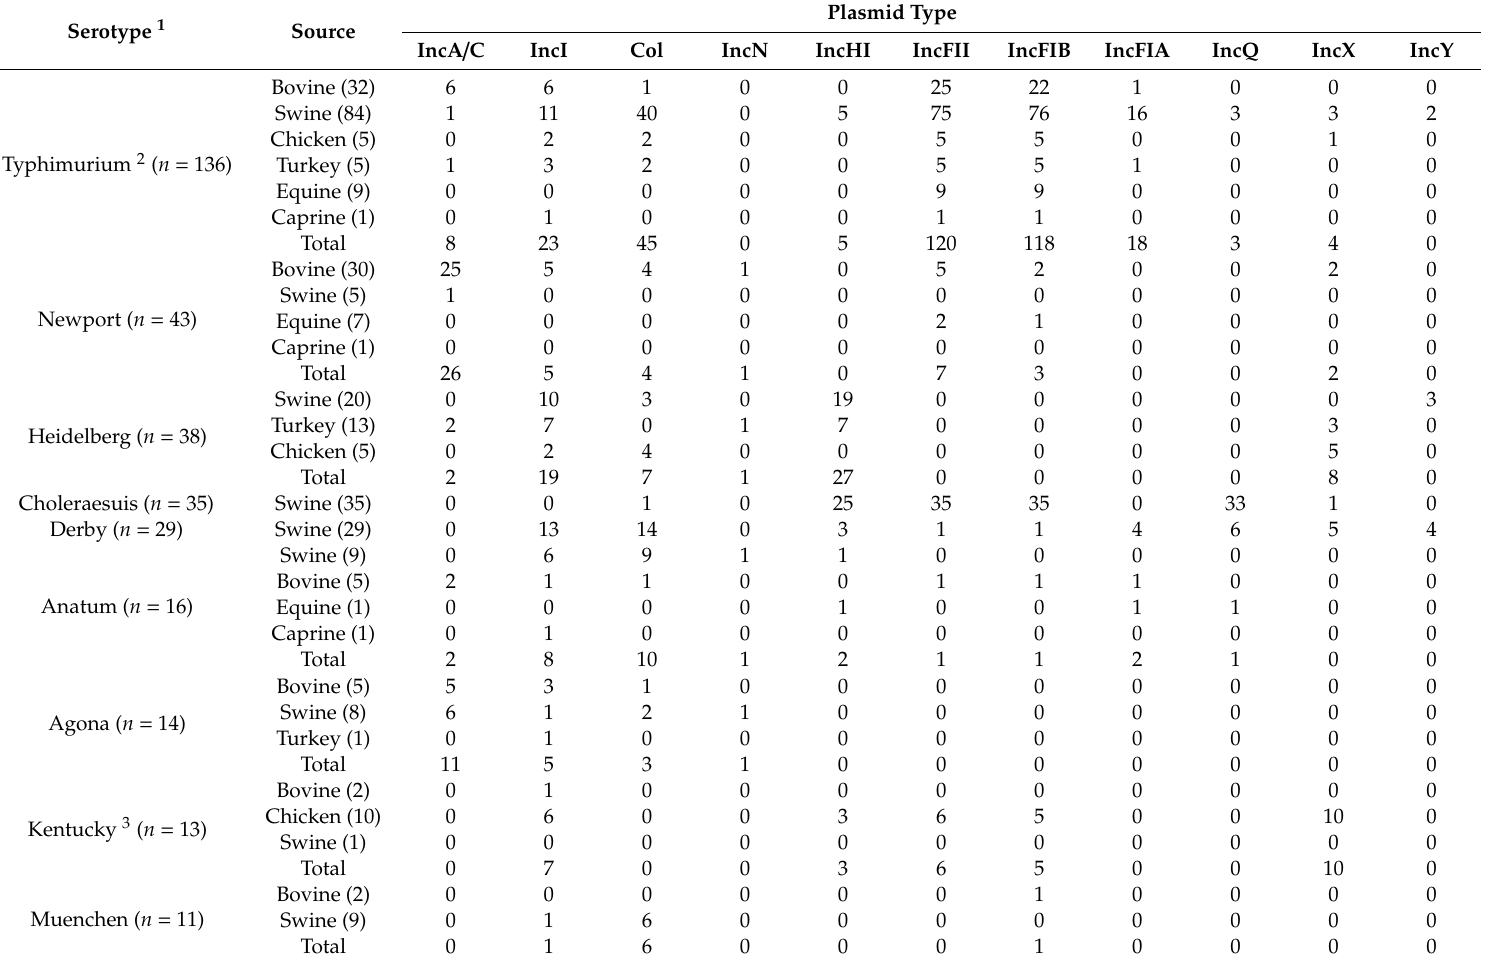
Table 3. Plasmid type associated with Salmonella serotypes and source of